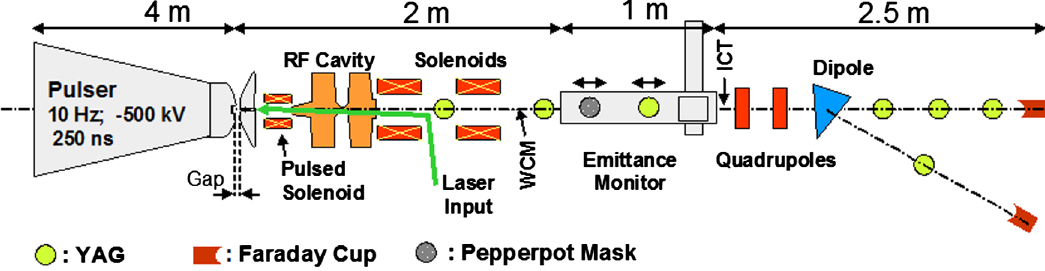
FIG. 12. Accelerator beamlinewiththe500kVpulserandthetwo-cell1.5GHzrfstructure.TheUVlaserissteeredontothecathodevia an in-vacuum mirror located downstream the rf cavity. WCM: wall current monitors; ICT: integration current transformer